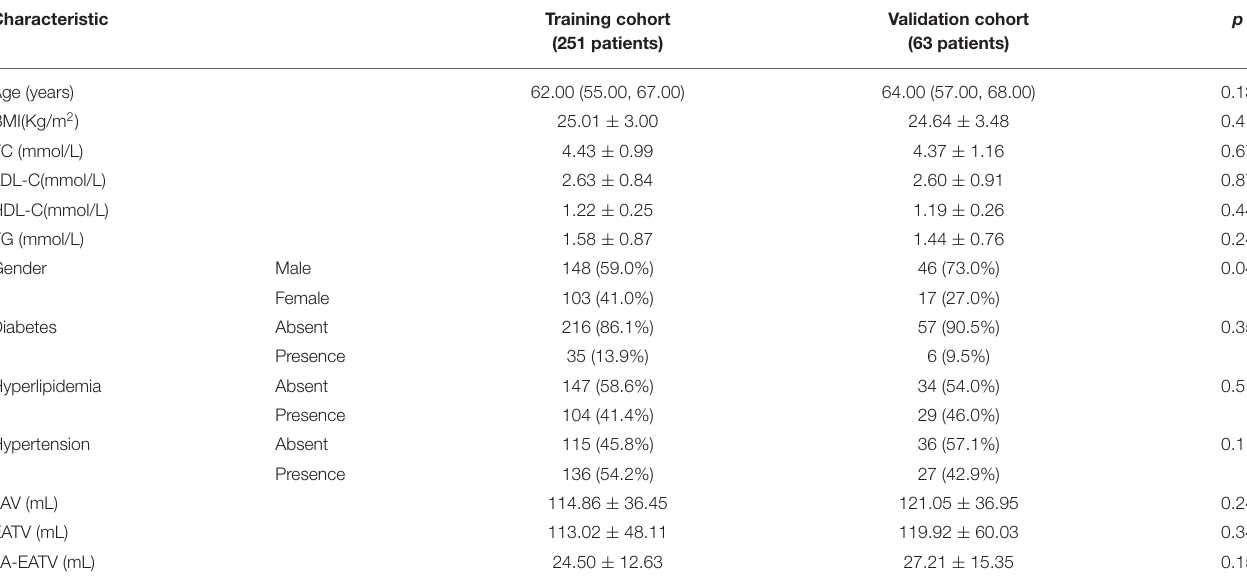
TABLE 1 | Clinical characteristics and morphological parameters in the training and validation cohorts.